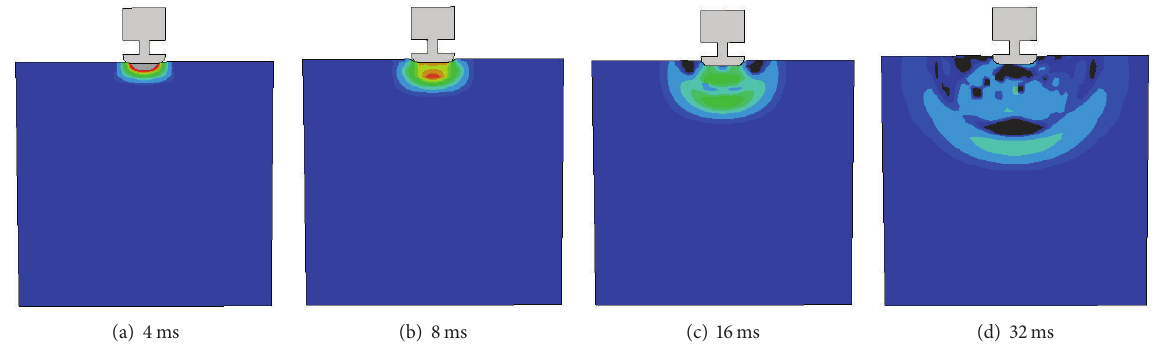
Figure 29: Propagation of compression wave when 𝐷 𝑟 = 60 %, V = 4 m/s, and 𝑚 = 3 kg.